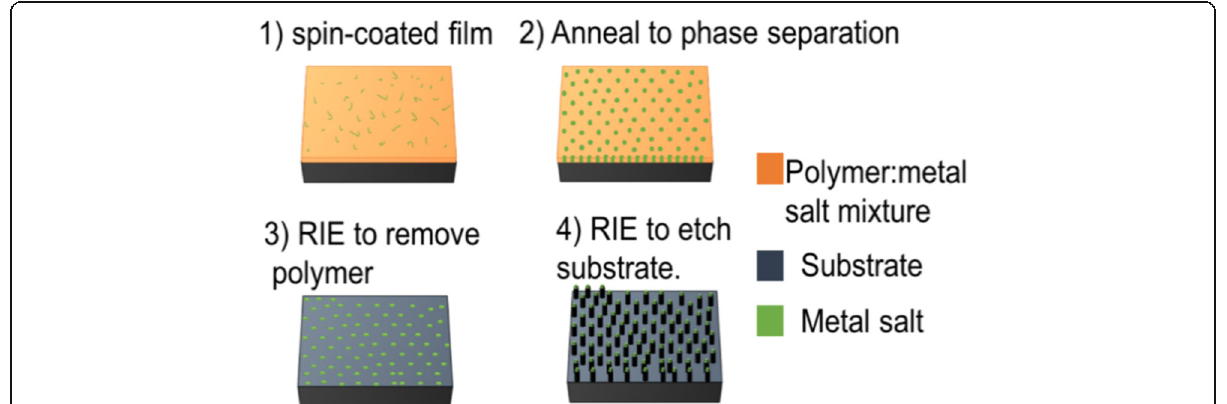
Fig. 1 Fabrication process of ultra-high resolution nanostructures using self-assembly of metal salt – polymer nanocomposite film. (1) Spin-coating film from a solution containing polymer and salt. (2) Phase separation by thermal annealing. (3) Etching polymer using oxygen plasma and leav- ing behind metal salt nanoislands on silicon. (4) Etching silicon using fluorine based plasma with metal salt nanoislands as mask